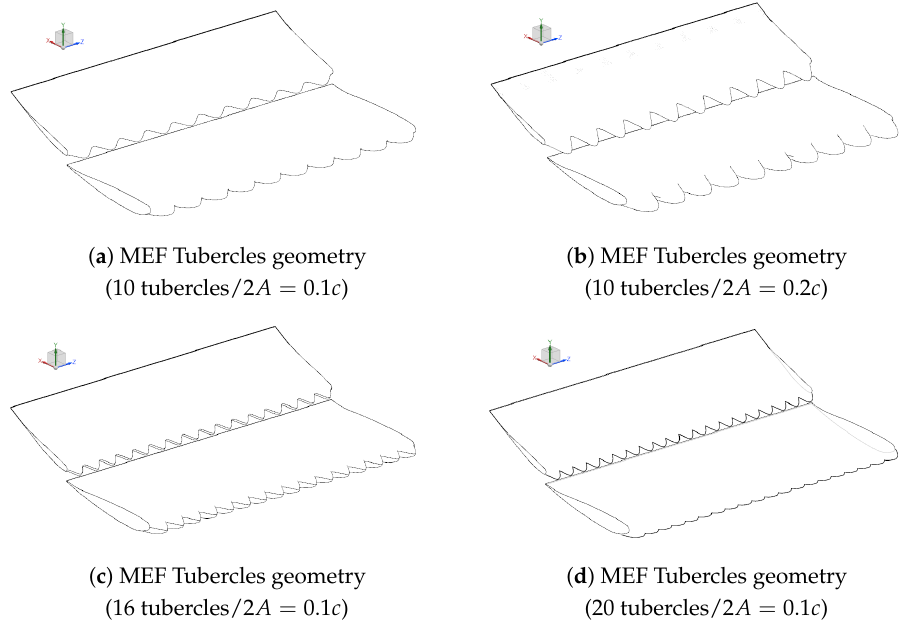
Figure 16. All geometries with tubercles of Step